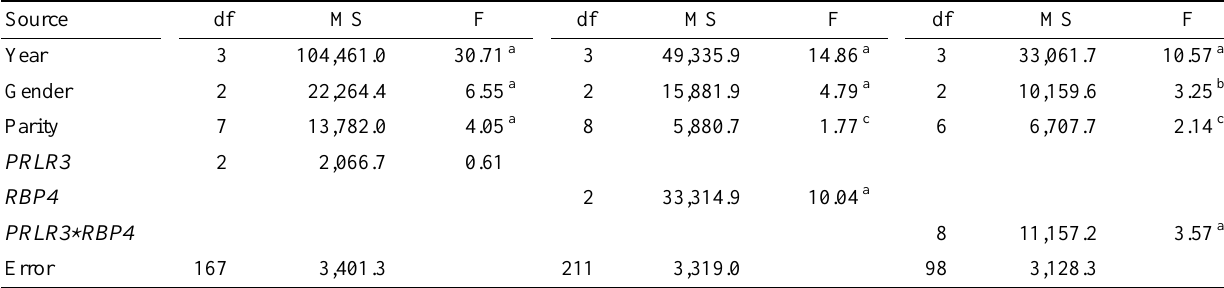
Table 6. Analysis of variance for average daily